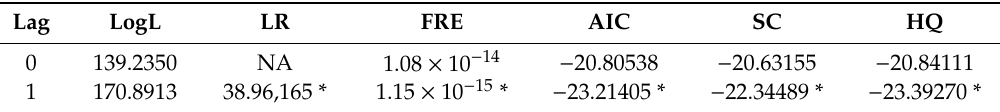
Table 4. Lag length criteria.